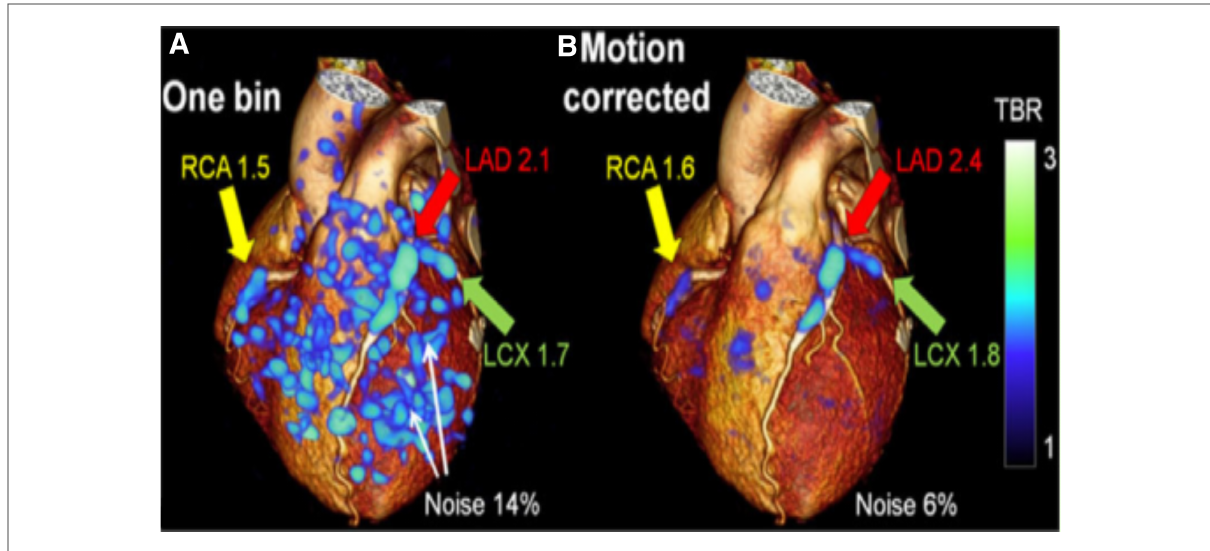
FIGURE 6 3D CT-PET: Target-to-background re fi nement and noise reduction with ( A ) The 1-bin image (25% of PET counts) (90); ( B ) Motion-corrected image overlayed on rendered CCTA volume. Increased plaque update is seen in RCA, LAD, and LCX coronary arteries in the high noise 1-bin image and remains clear in the motion-corrected image. RCA, right coronary artery, LAD, left anterior descending, LCX, left circum fl ex artery